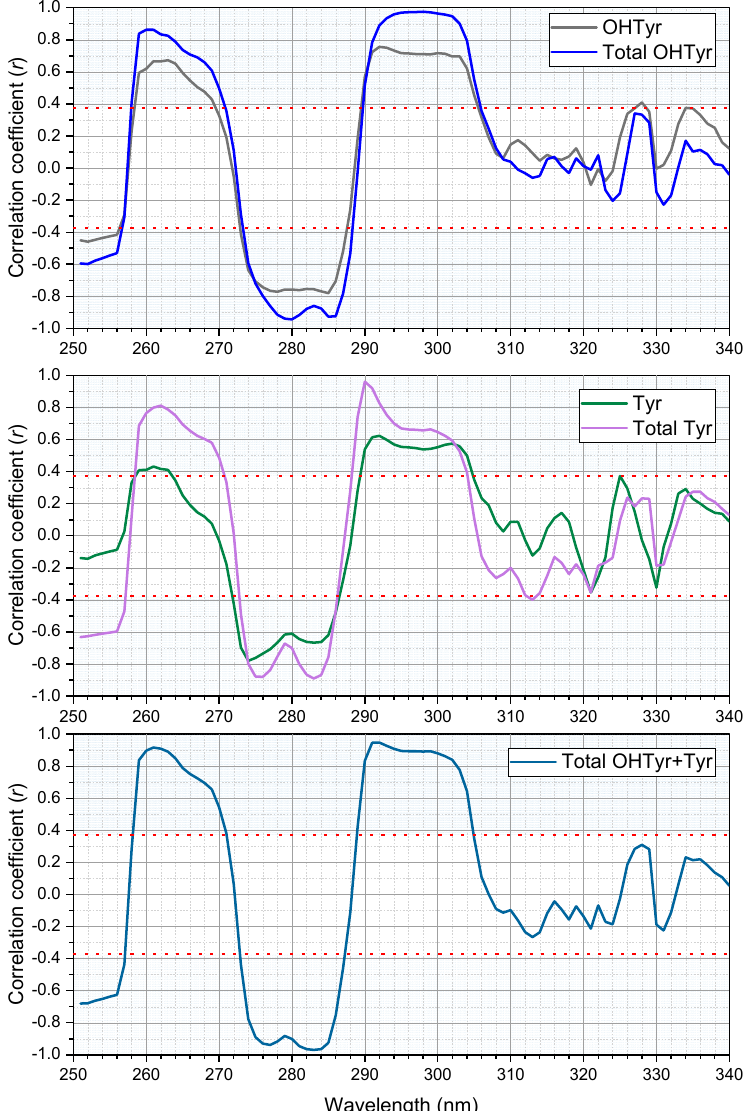
Figure 3. Correlation plots of the second derivatives of absorbance of the NADES extracts ( n = 26) versus the content of free (before hydrolysis) and total (after hydrolysis) OHTyr and Tyr, and their sum. The red dotted lines and the light blue areas indicate the thresholds of significance ( p = 0.05).